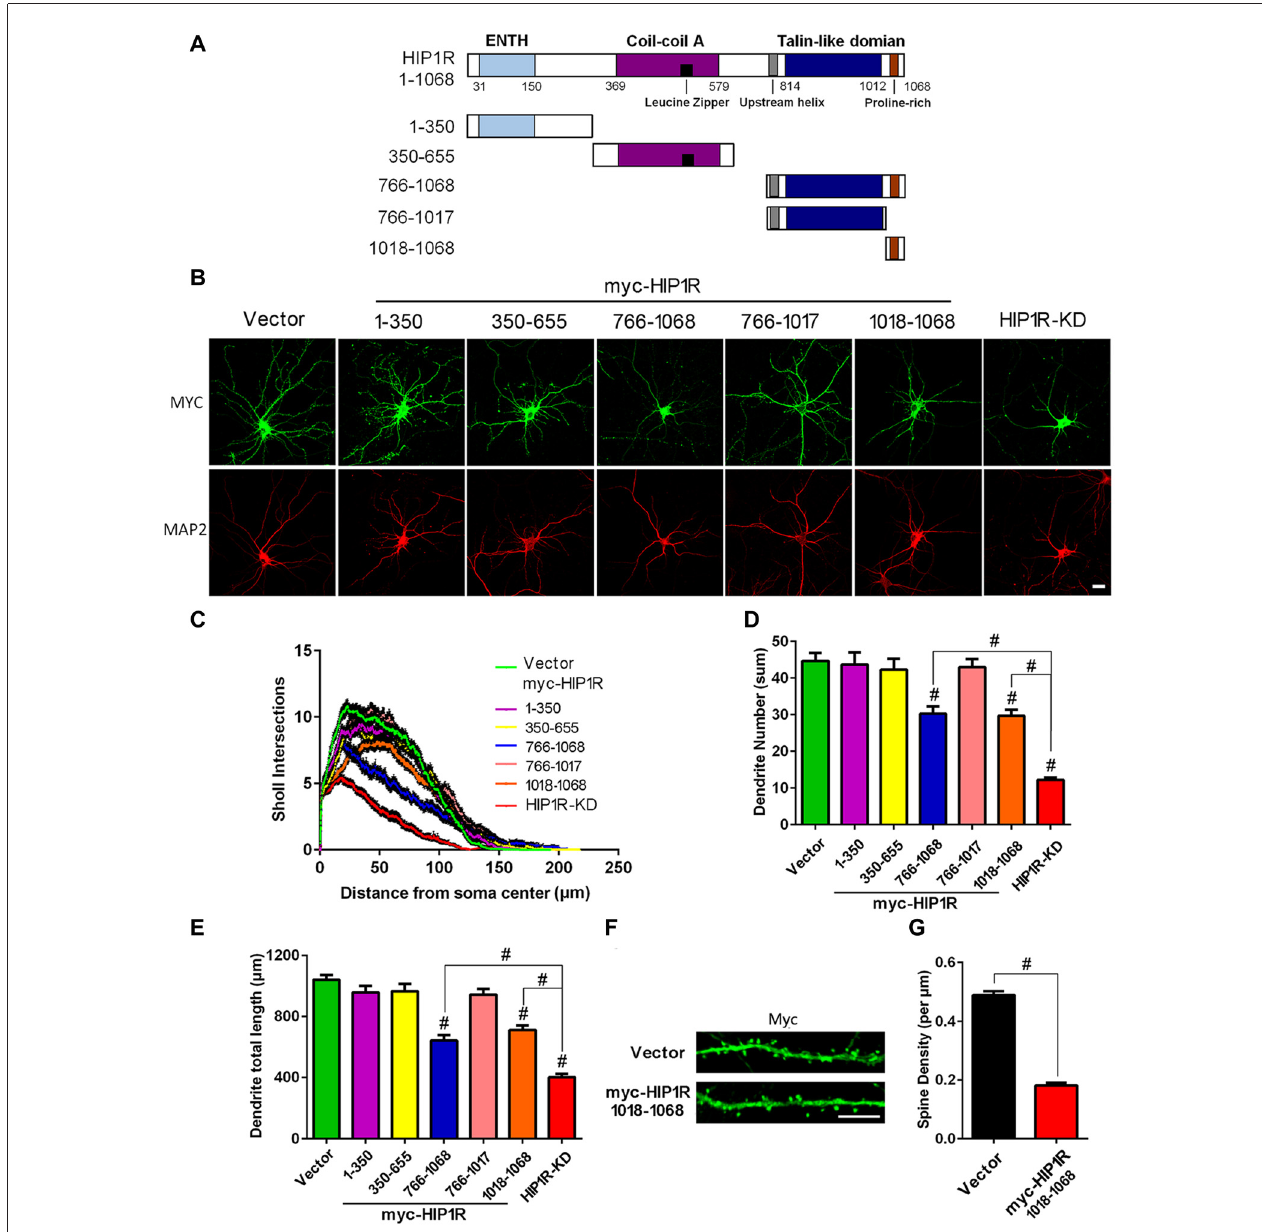
FIGURE 8 | Expression of the HIP1R C-terminus and its proline-rich region confer a dominant negative effect on dendrite development. (A) A schematic illustration showing full-length and several truncated forms of HIP1R cDNA in the myc-tagged expressing vector. (B) Cultured hippocampal neurons were transfected at DIV6 with each of the myc-tagged HIP1R mutants. An empty vector was taken as a negative control and GFP-shRNA as a positive control. Representative images of transfected neurons are shown immunostained at DIV12 with myc and MAP2 antibodies. Scale bar=20 µ m. (C) ANOVA with repeated measures for Sholl analysis showed a significant decrease in dendrite complexity in HIP1R 766–1068 and HIP1R 1018–1068 transfected neurons. (D,E) Quantitative analysis with unpaired two-tailed t -tests showed a partial decrease in dendrite number and total length in HIP1R 766–1068 and HIP1R 1018–1068 transfected neurons compared to the negative and positive controls. Dendrite number: 44.69 ± 2.18, n = 42 for the negative control (CTL); 43.70 ± 3.30, n = 46 for myc-HIP1R 1–350 ; 42.30 ± 2.95, n = 44 for myc-HIP1R 350–655 ; 30.21 ± 2.03, n = 48 for myc-HIP1R 766–1068 ; 42.98 ± 2.23, n = 42 for myc-HIP1R 766–1017 ; 29.70 ± 1.59, n = 40 for myc-HIP1R 1018–1068 ; 12.17 ± 0.68, n = 42 for the positive control (KD). Dendrite total length: 1041.91 ± 29.58 µ m, n = 42 for the negative control (CTL); 957.21 ± 42.99 µ m, n = 46 for myc-HIP1R 1–350 ; 965.05 ± 47.24 µ m, n = 44 for myc-HIP1R 350–655 ; 642.64 ± 34.09 µ m, n = 48 for myc-HIP1R 766–1068 ; 942.51 ± 37.93 µ m, n = 42 for myc-HIP1R 766–1017 ; 711.39 ± 30.27 µ m, n = 40 for myc-HIP1R 1018–1068 ; 401.25 ± 21.66 µ m, n = 42 for the positive control (KD). (F,G) Myc-vector or myc-HIP1R1018–1068 plasmid was transfected into DIV6–7 hippocampal neurons. Transfected neurons were stained with anti-myc antibody to analyze the spine density at DIV18–21. Spine density per µ m: 0.18 ± 0.01, n = 55 for myc-HIP1R1018–1068 vs. 0.49 ± 0.01, n = 55 for the vector control. All data are presented as mean ± SEM. # P <